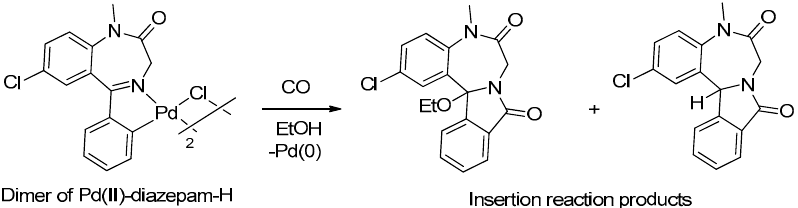
Figure 6. Example of an insertion reaction of CO in the Pd-C bond of palladacycles derived from BZDs.